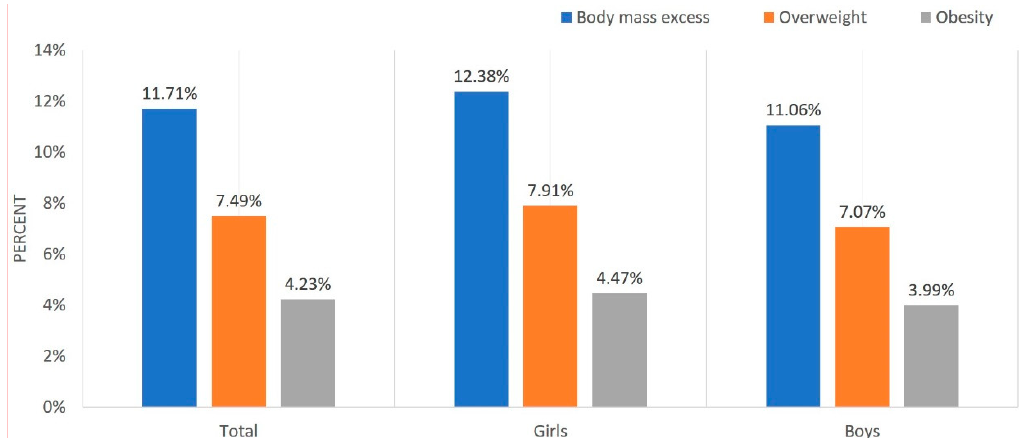
Figure 1. Prevalence of overweight and obesity in the study group.